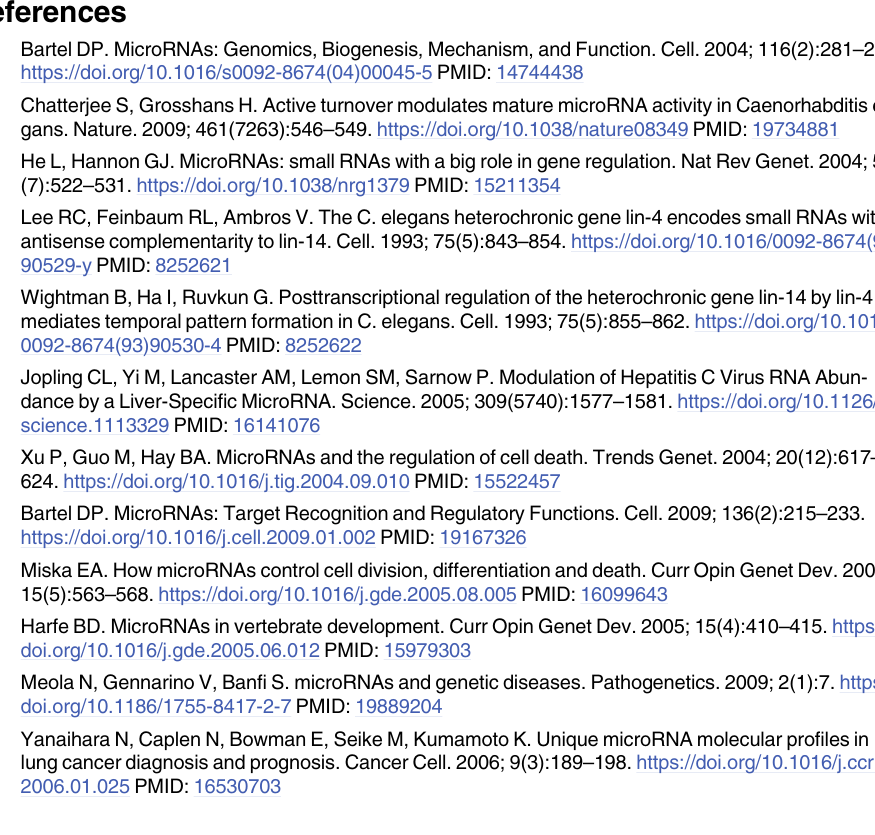
S7 Table. The constructed miRNA sequence similarity score